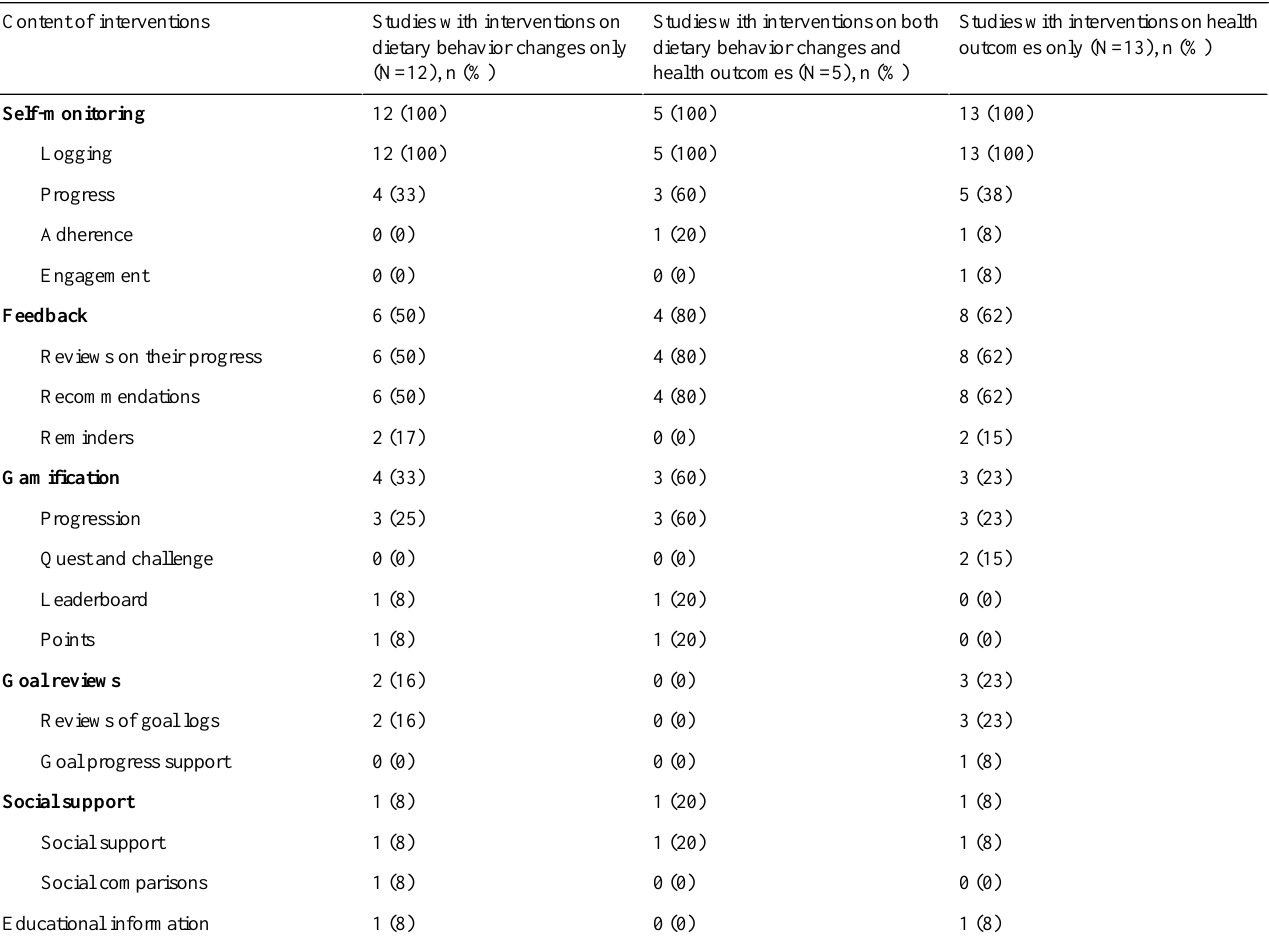
Table 1. Content of interventions and effects.